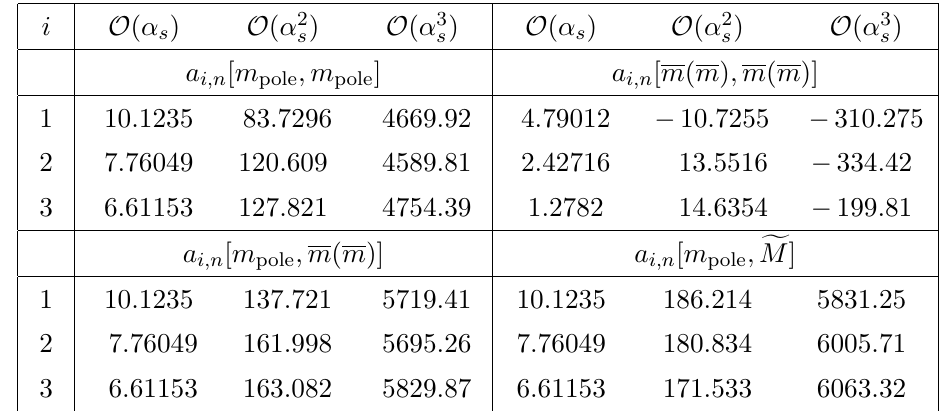
Table 3. a i;n ( m Q ; m 0 ) coe(cid:14)cients of the perturbative expansion for the mass-subtracted linearized Q moments, as displayed in eq. (4.26), at one (left column of each block), two (middle column of each block), and three (right column of each block) loops. The numerical values correspond to the case n ‘ = 4, studied in this section. The table is split into four blocks: the upper left one corresponds to the pole mass expansion in terms of the pole mass, the upper right one shows the MS mass expansion in terms of the MS mass, the lower left block displays the pole mass expansion in terms of the MS mass, and the lower right displays the linearized iterative expansion for the pole